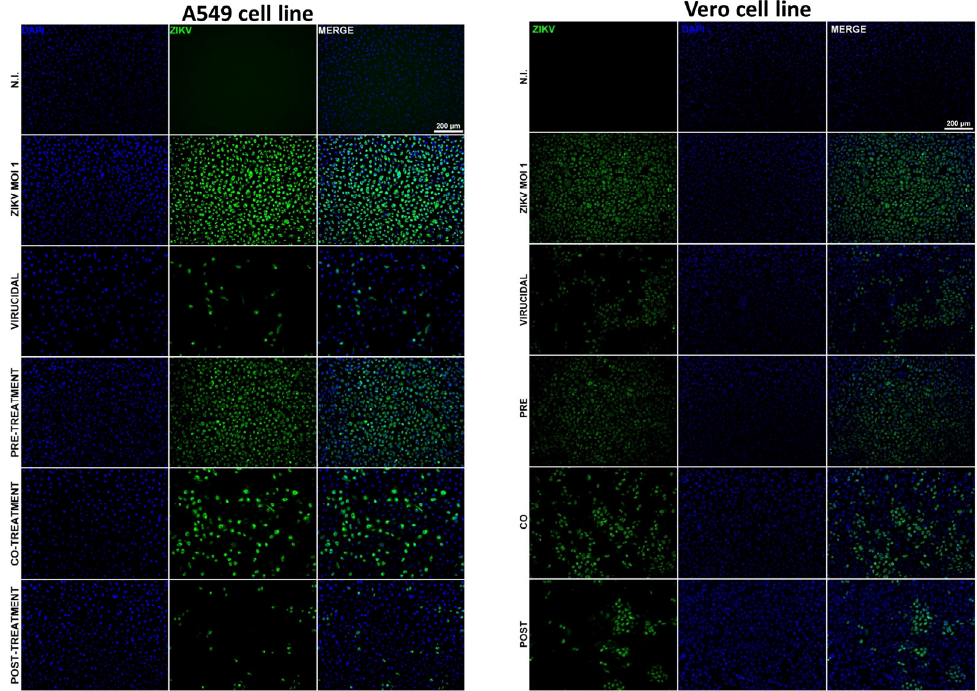
Figure 3. Evaluation of antiviral effect by indirect immunofluorescence assay (IFA). ZIKV was cultured at MOI = 1 in A549 or Vero cells with 125 µ M quercetin hydrate. Non-infected cells and ZIKV-infected cells without compound were used as controls. After 12 h of incubation with the treatments, cells were fixed, and the expression of ZIKV E protein (in green) was detected with anti-E protein 4G2 mouse primary antibodies, followed by Alexa Fluor 488 mouse secondary antibody. Cell nuclei were stained with DAPI (in blue).